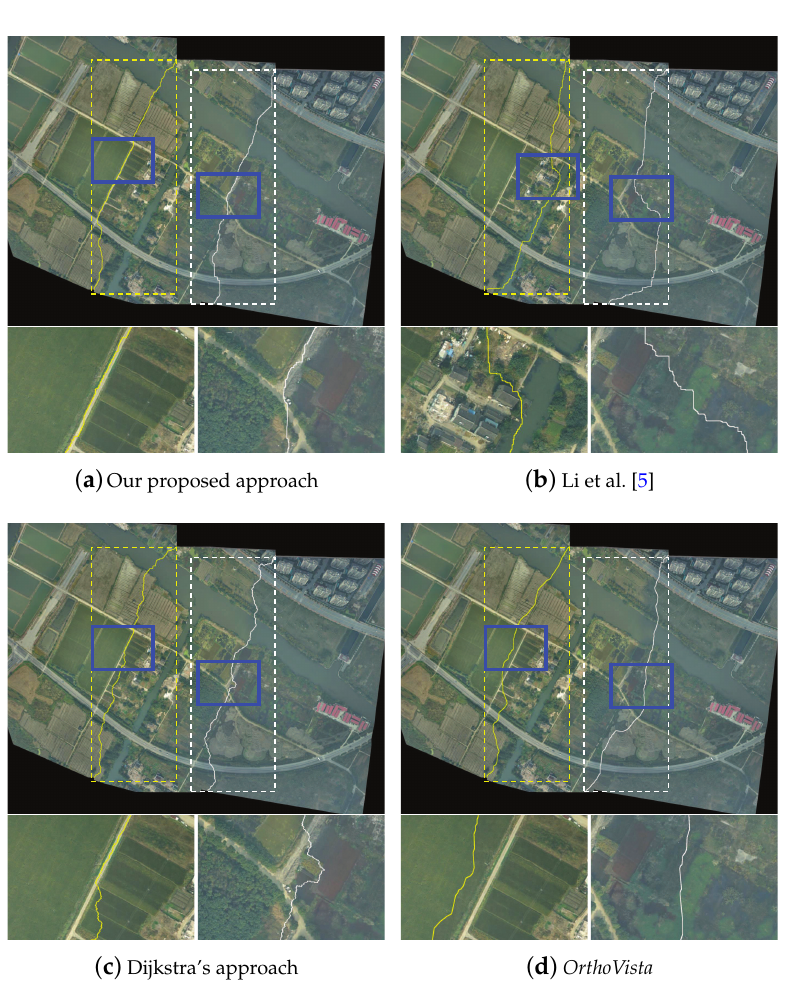
Figure 14. The seamlines detected by our proposed approach ( a ); Li et al. [5] ( b ); Dijkstra’s approach ( c ) and OrthoVista ( d ) on one non-urban area. The dash boxes represent the overlapped regions between input